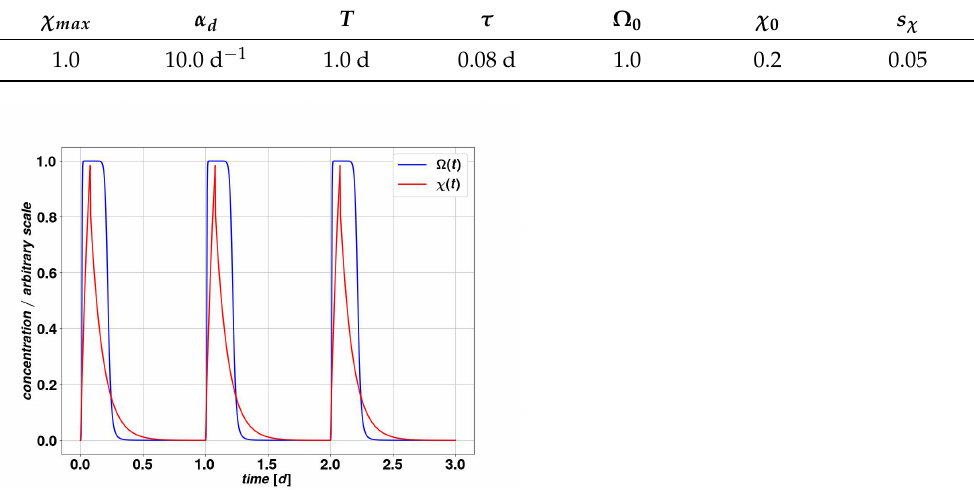
Figure 4. The concentration of the substance in the organism, labeled as χ ( t ) in blue according Equation (2) and the action function Ω ( t ) in red as in Equation (3) during 3 periods. The parameters correspond to those displayed in Table